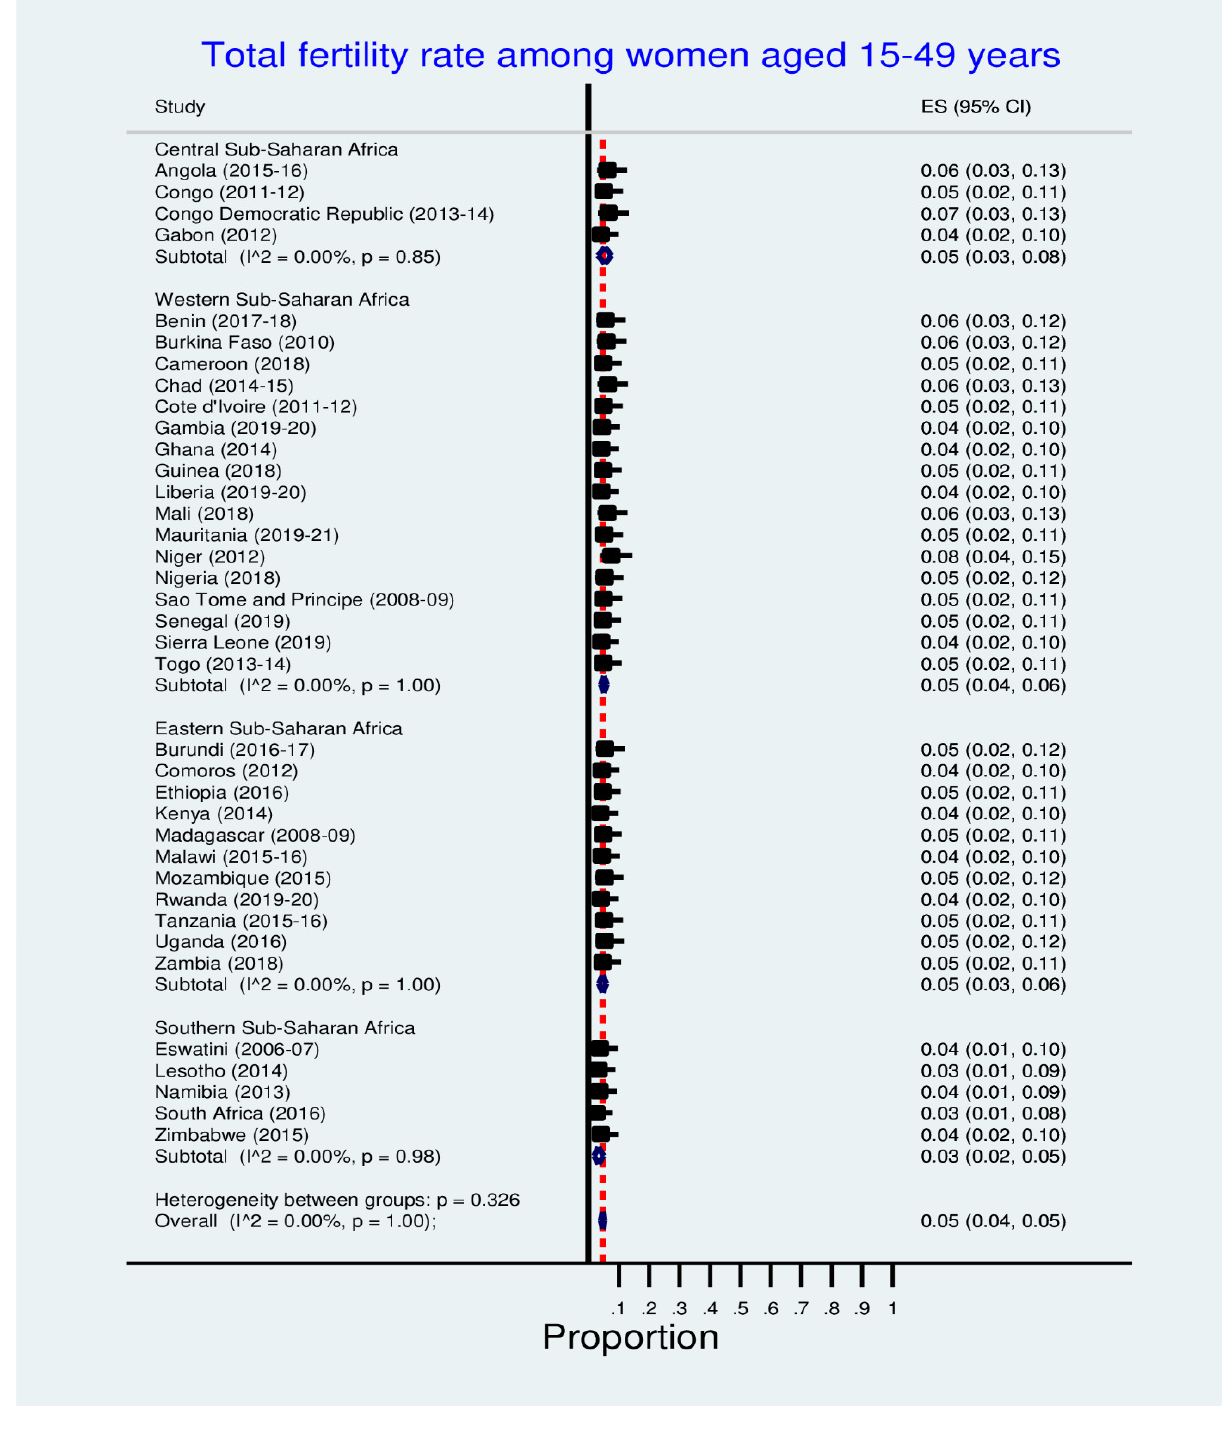
Figure 4. Total fertility rate among women aged 15–49 years.